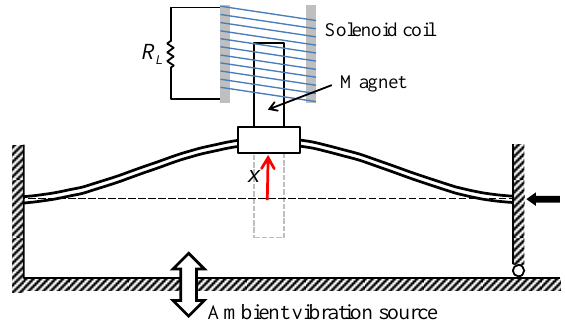
Figure 1. Schematic diagram of an electromagnetic bi-stable energy harvester composed of a clamped-clamped beam and an external solenoid coil. The right end of the beam is movable in the horizontal direction but can also be fastened at a certain position. The gravitational field is assumed to be in the perpendicular direction to the given plane.